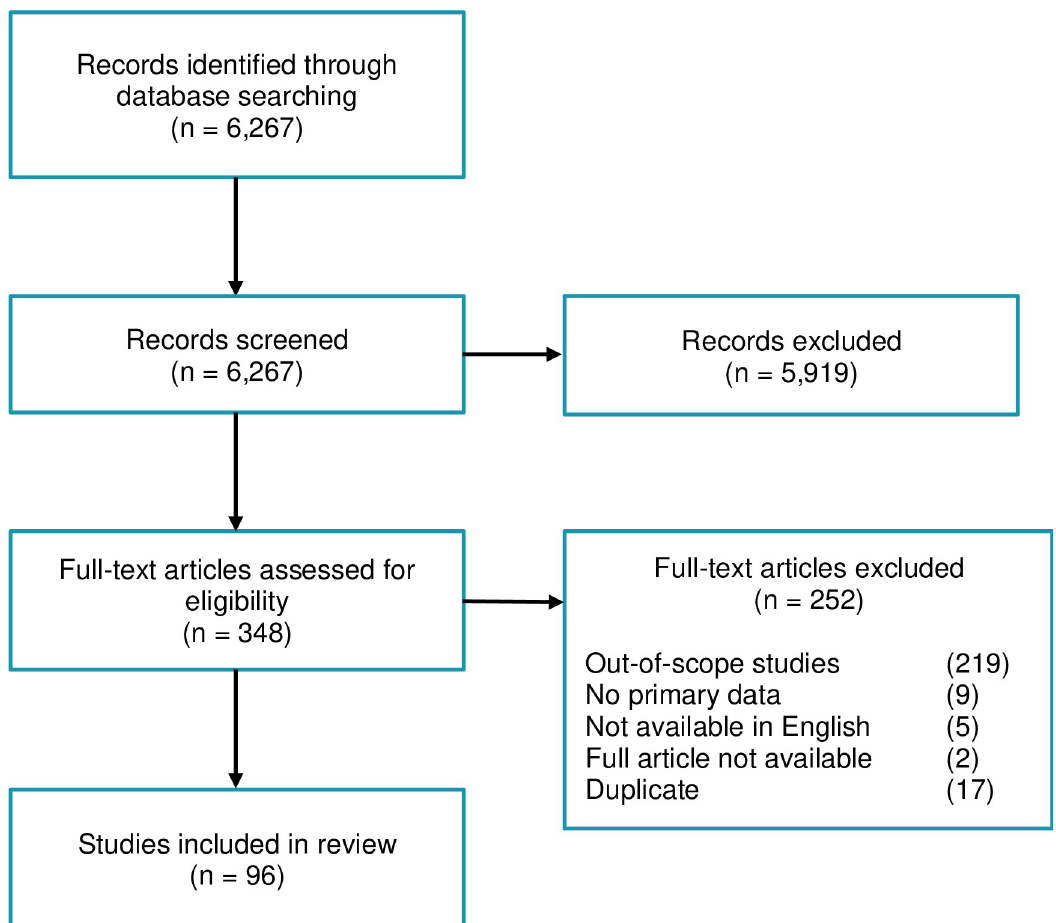
Fig 1. Summary of screening and exclusion steps of this scoping review’s methodology, and resulting number of publications after each step.